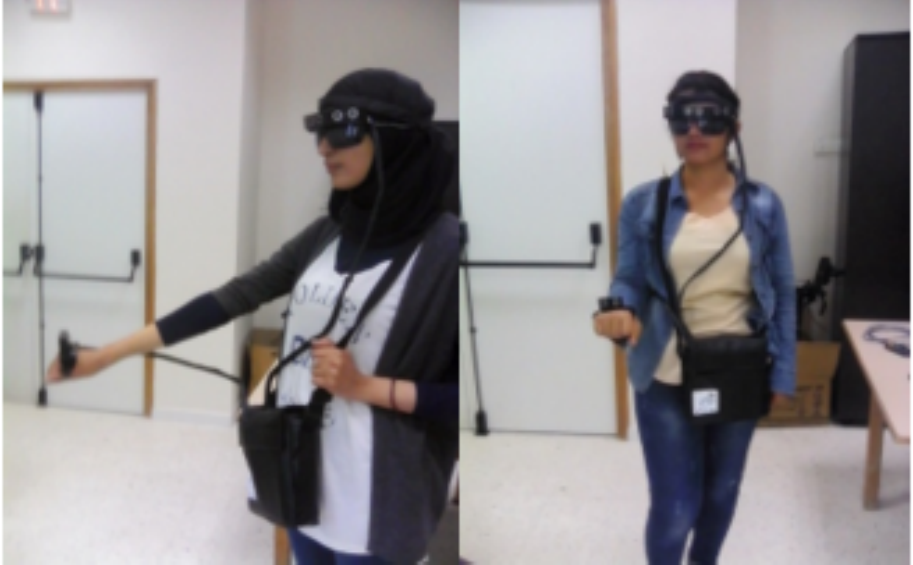
Figure 8. Preliminary tests and validation with healthy